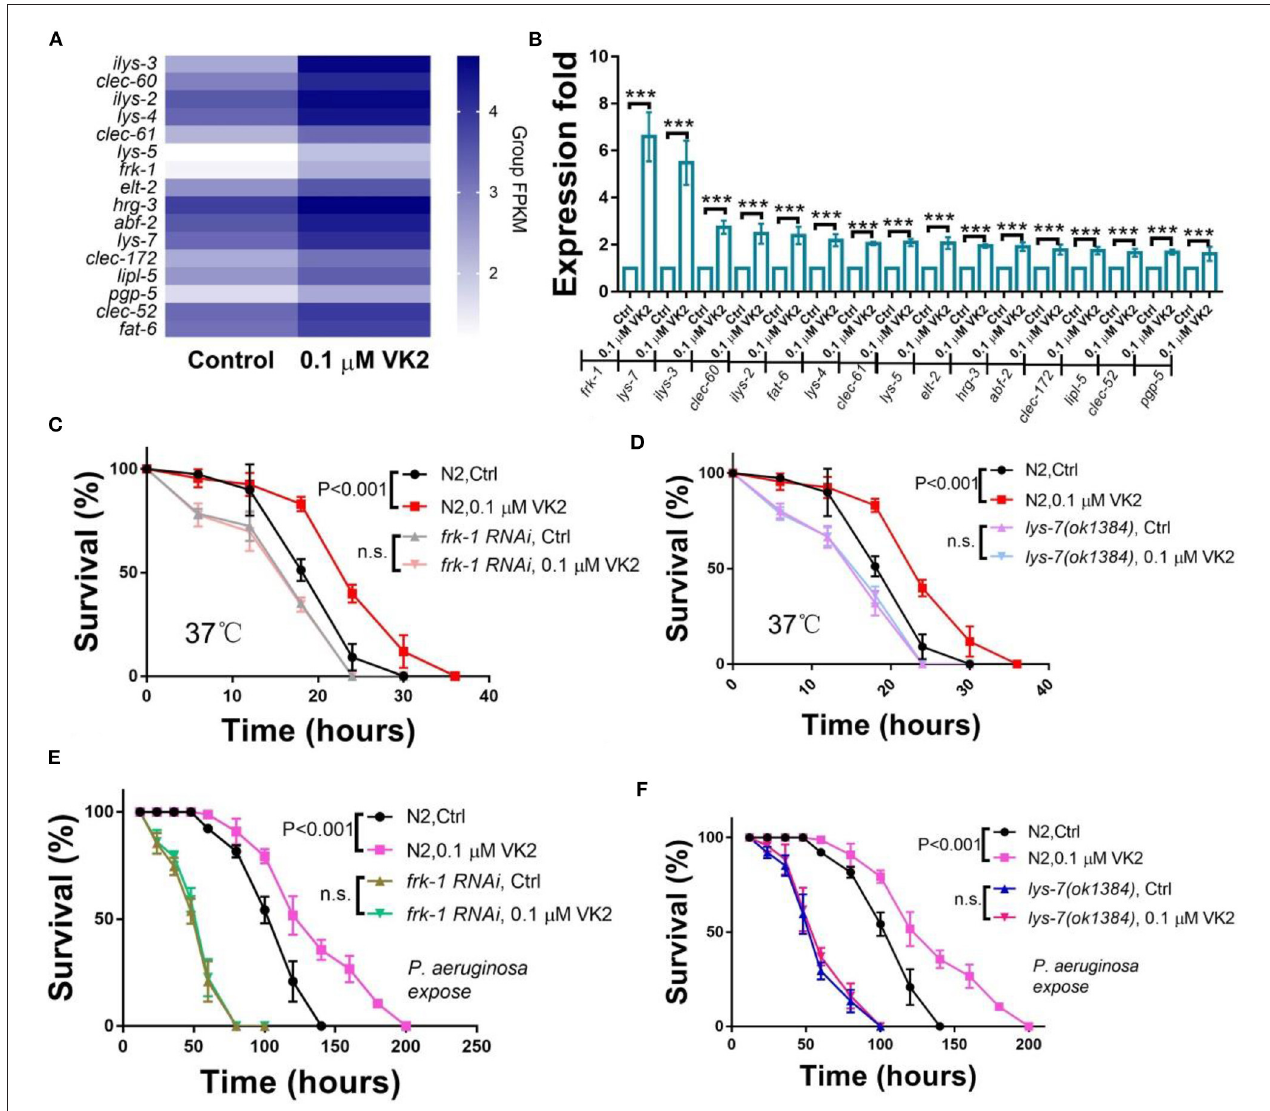
FIGURE 3 | VK2 improves stress resistance mainly through frk-1 and lys-7. (A) The biological processes associated with the genes up-regulated by VK2 were analyzed using GO. Sixteen genes were involved in defense response GO terms. Heat-map analysis of these genes was carried out using Group FPKM based on RNA-seq data. (B) The expression levels of these 16 genes were further confirmed using real-time PCR. *** P < 0.001. The function of VK2 on survival was absent in frk-1 RNAi worms (C) and lys-7 mutants (D) . Also, VK2 failed to significantly improve the survival of frk-1 RNAi worms (E) and lys-7 mutants (F) cultured with the infective pathogen P. aeruginosa . The treatments were repeated at least three times, and the sample size was larger than 60 in each experiment. The P -values were determined by using a t -test. n.s., no significant